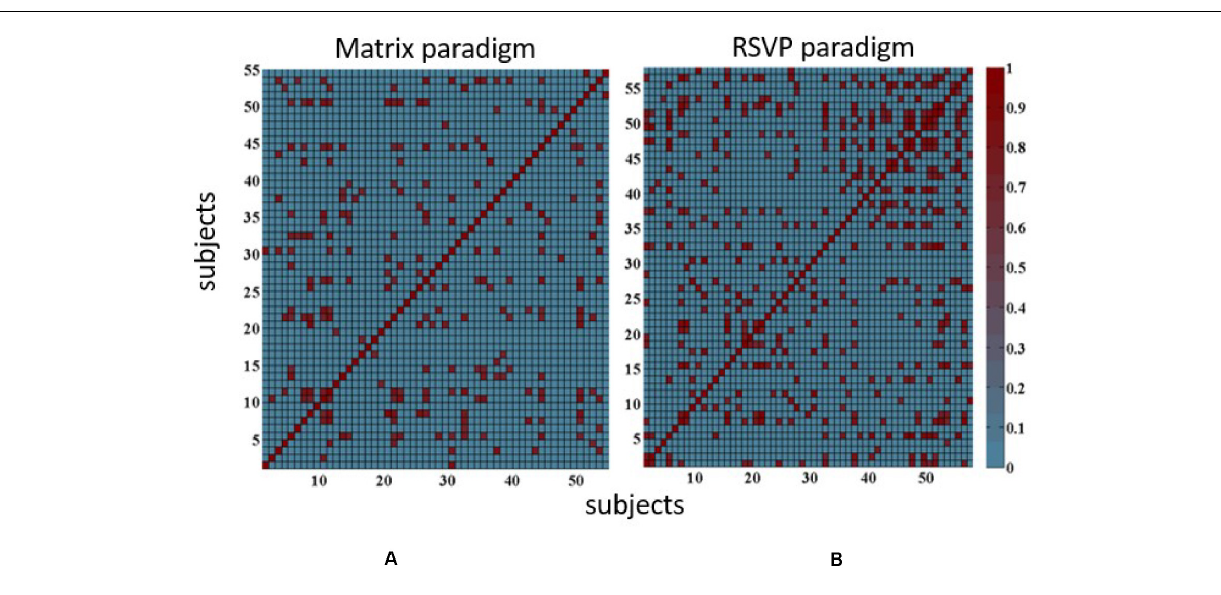
FIGURE 6 | Statistical results of angle cosine values for (A) matrix paradigm and (B) RSVP